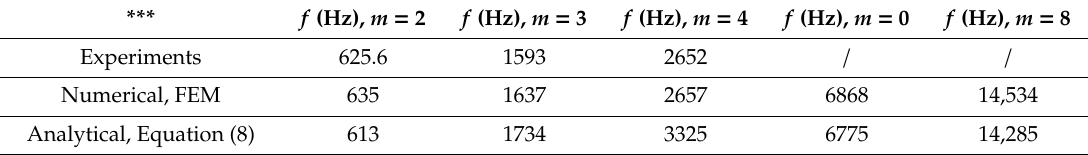
Table 3. Comparison of experimental, numerical and analytical results for the stator without windings.